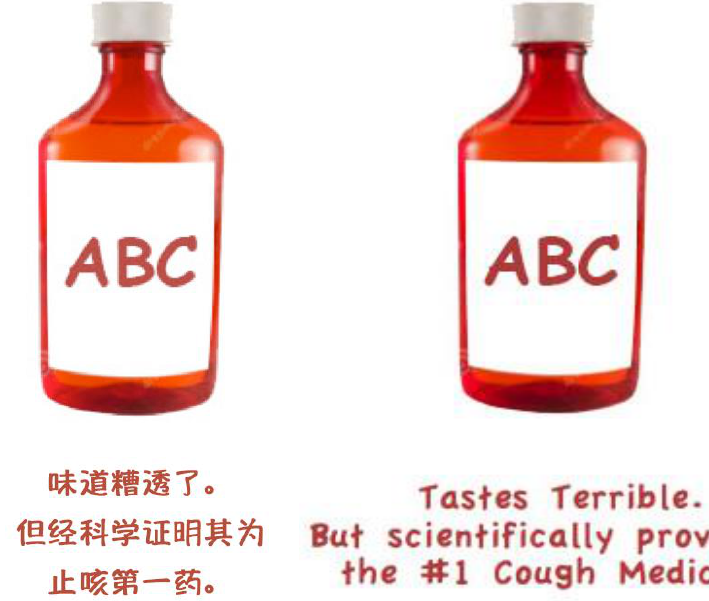
Figure 4. Advertising copies.